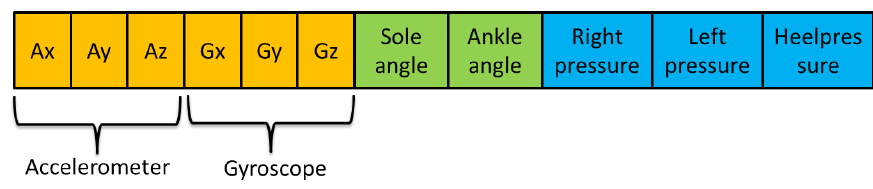
Figure 13. Frame sent by Arduino.